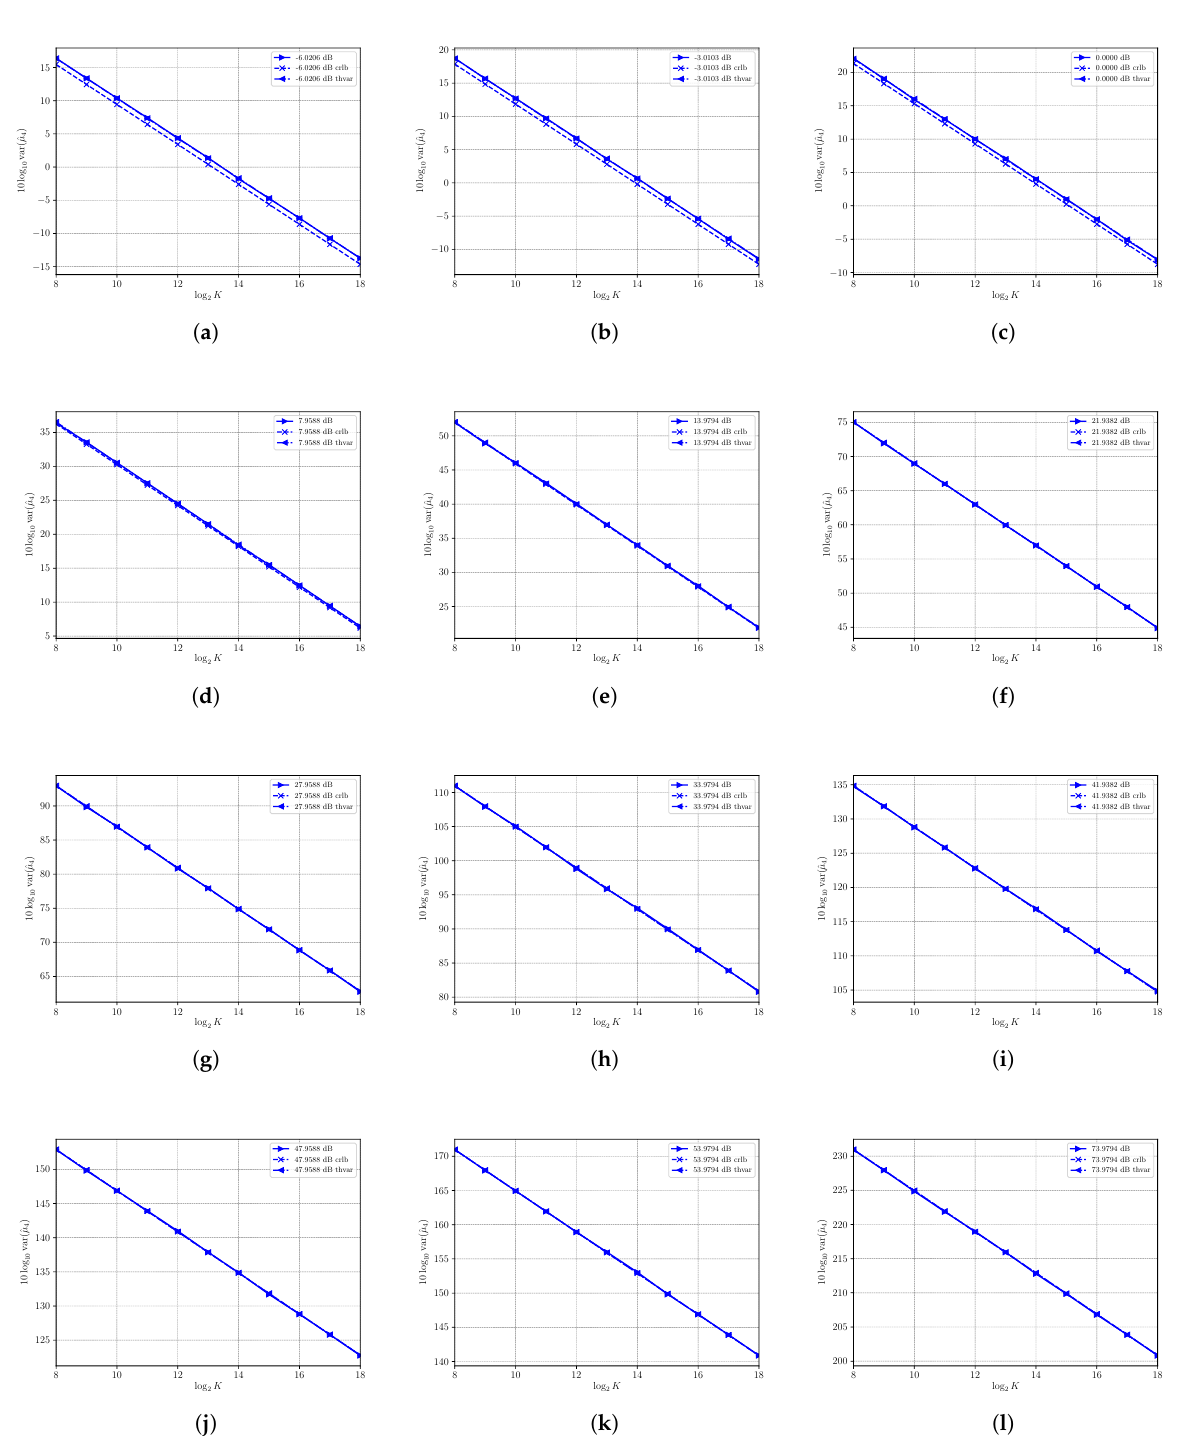
Figure 2. Asymptotic and estimated variances of the moment estimator ˆ µ 4 versus the number of observations K . Each sub figure ( a – l ) shows results for a given nominal value of SNR obtained by changing the signal power S and with noise power N =